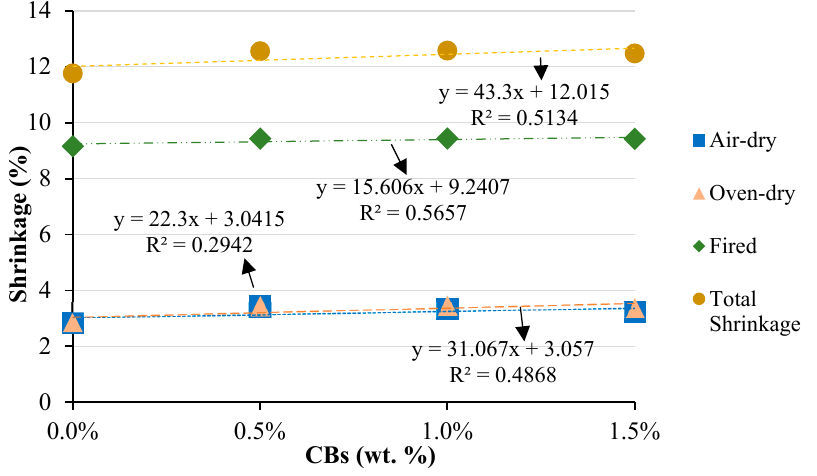
Figure 4. Shrinkage rate versus CB% by mass.